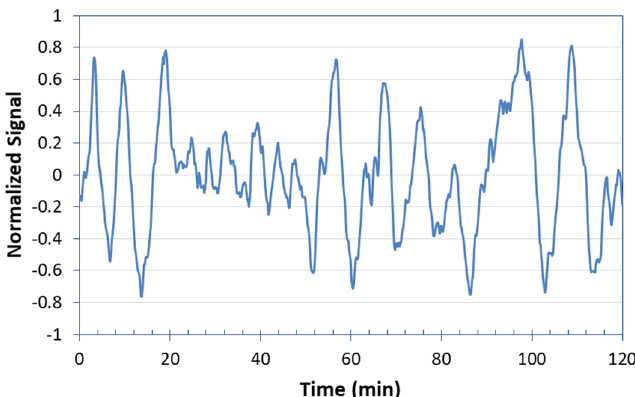
Figure 5. Normalized 2 h average standard deviation signal as a part of the 24 h frequency regula- tion duty cycle determined by Sandia National Laboratories